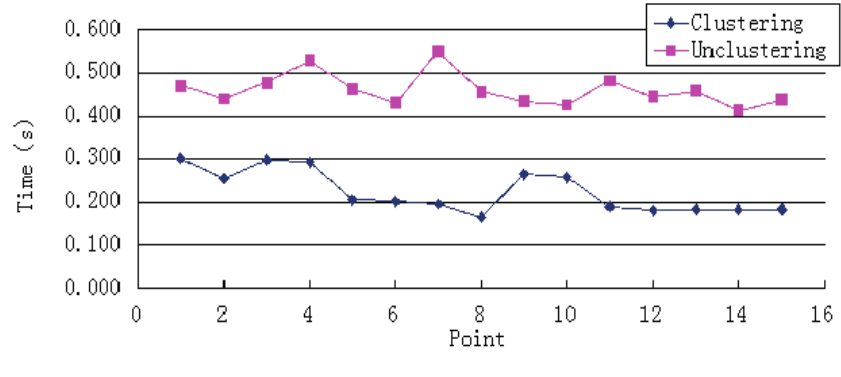
Figure 4. Single-point positioning time.